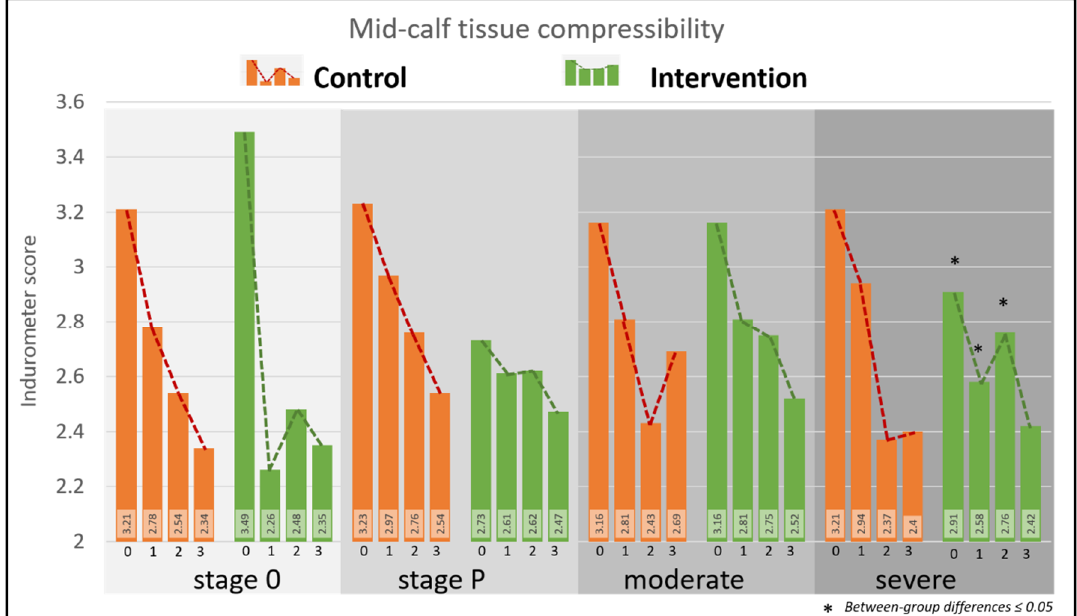
Figure 5. Change in Indurometer scores by group and stage.